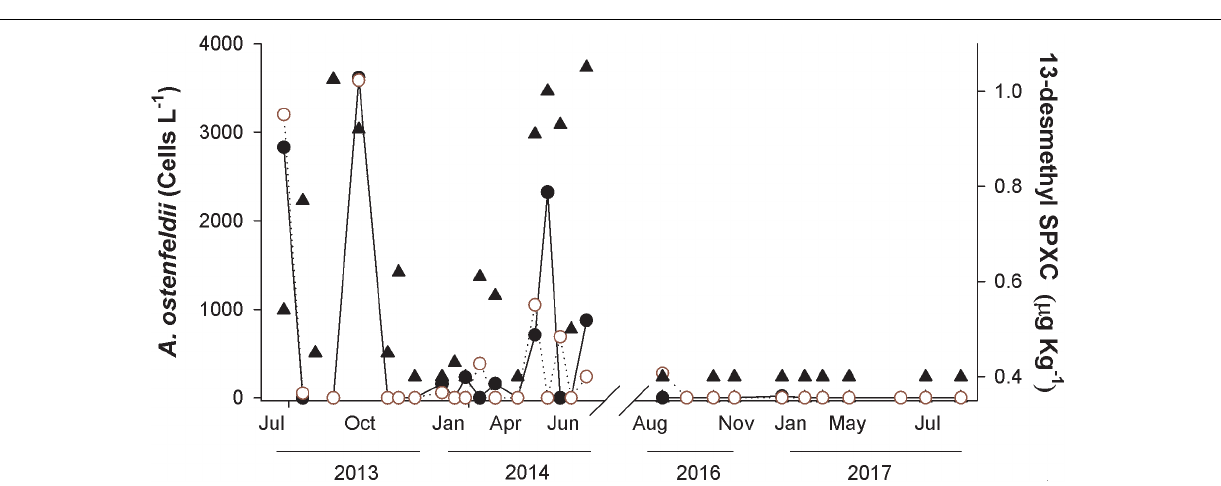
FIGURE 7 | Concentration of 13-desmethyl spirolide (SPX) C (closed triangles) in the Mediterranean mussel Mytilus galloprovincialis collected from July 2013 to June 2014 and from August 2016 to August 2017 in Rincón de Ballenas (Todos Santos Bay). The abundance of A. ostenfeldii cells at surface (closed circles) and at 10 m or thermocline depth (open circles) is also